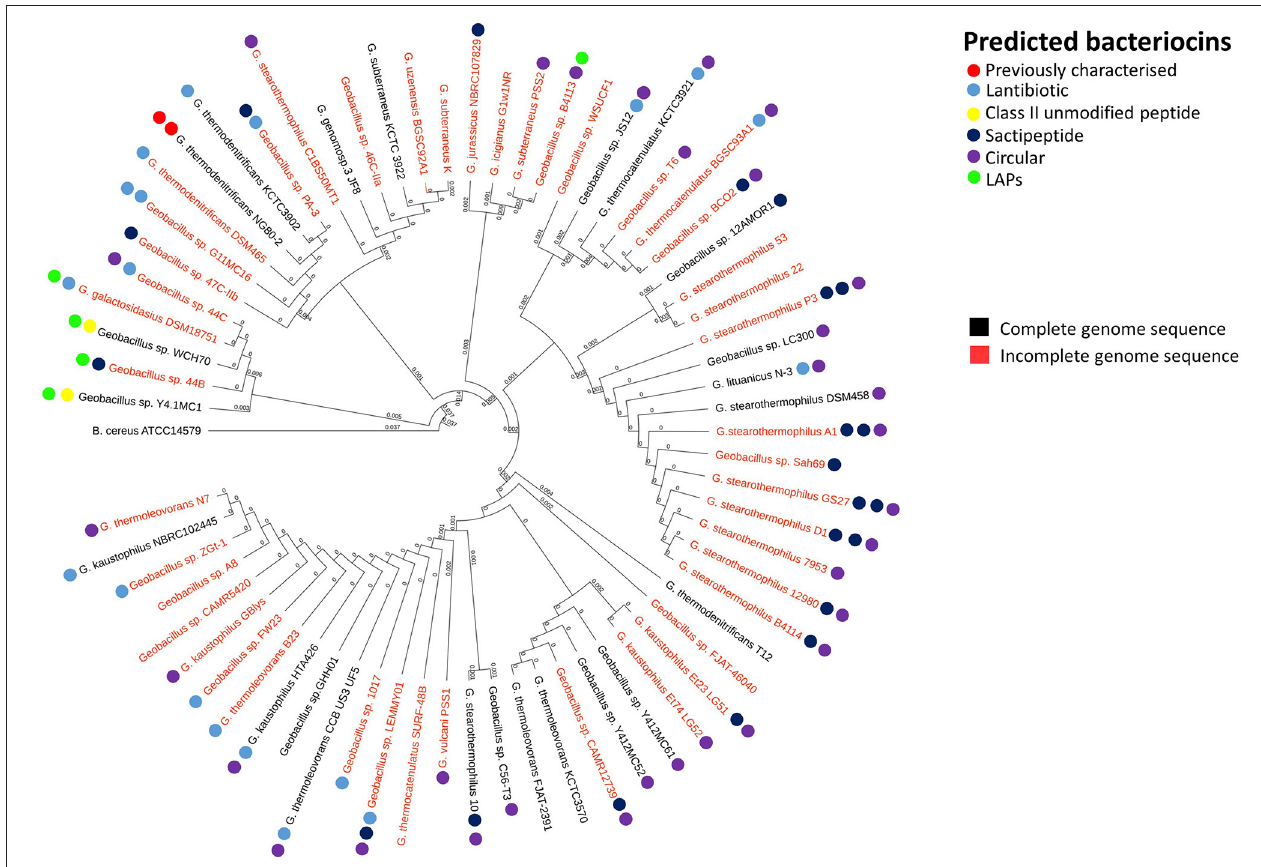
FIGURE 1 | Phylogenetic arrangement of Geobacillus genomes investigated in this study. The BAGEL3 peptide predictions are overlaid in order to examine associations between bacteriocin gene presence and position within the Geobacillus phylogenetic